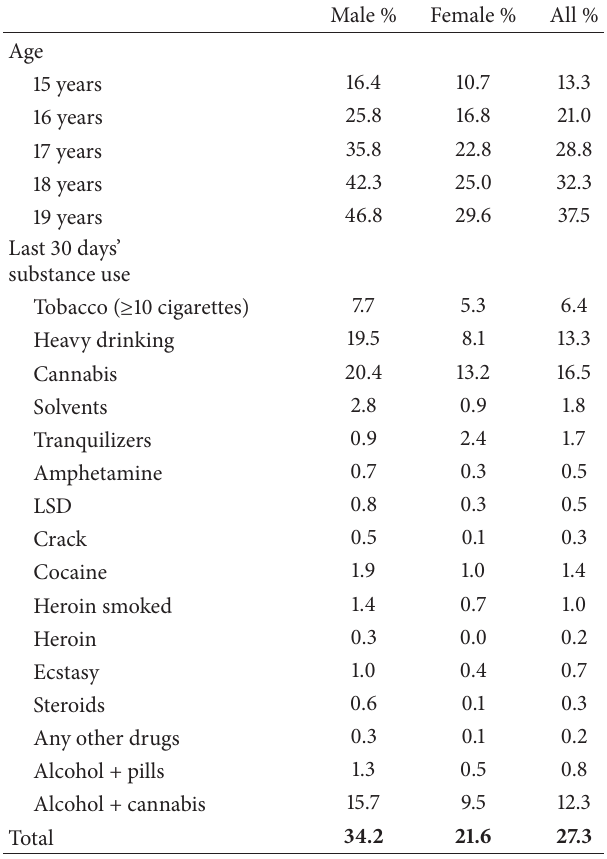
Table 1: Prevalence of drug, alcohol, and tobacco use among adolescents according to age, psychotropic substance, and